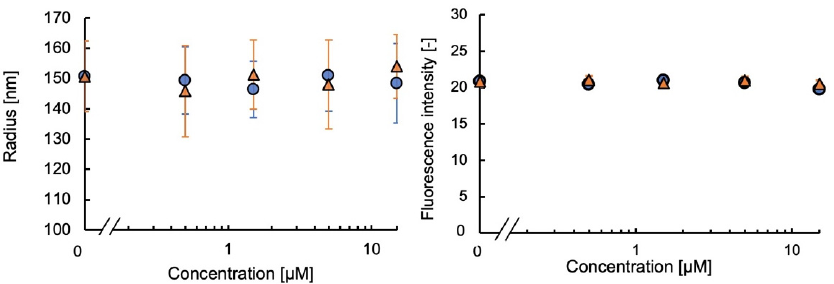
Figure 7. Effect of the dopamine (circles) and DOPA (triangles) on the radius ( left ) and fluorescent intensity ( right ) of the fNIP-NP synthesized with the dopamine template anchored with a mixture of APTMS and PTMS (3:7 in